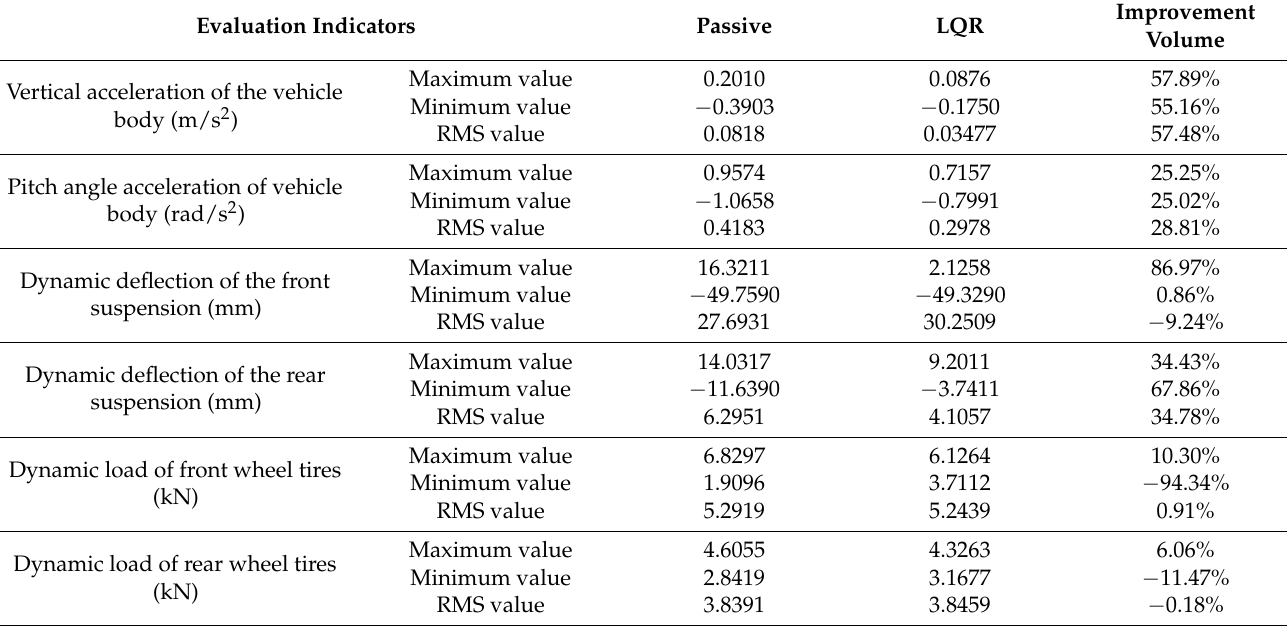
Table 8. Comparison of maximum, minimum, and RMS values for the simulation of high-speed driving conditions on Class C